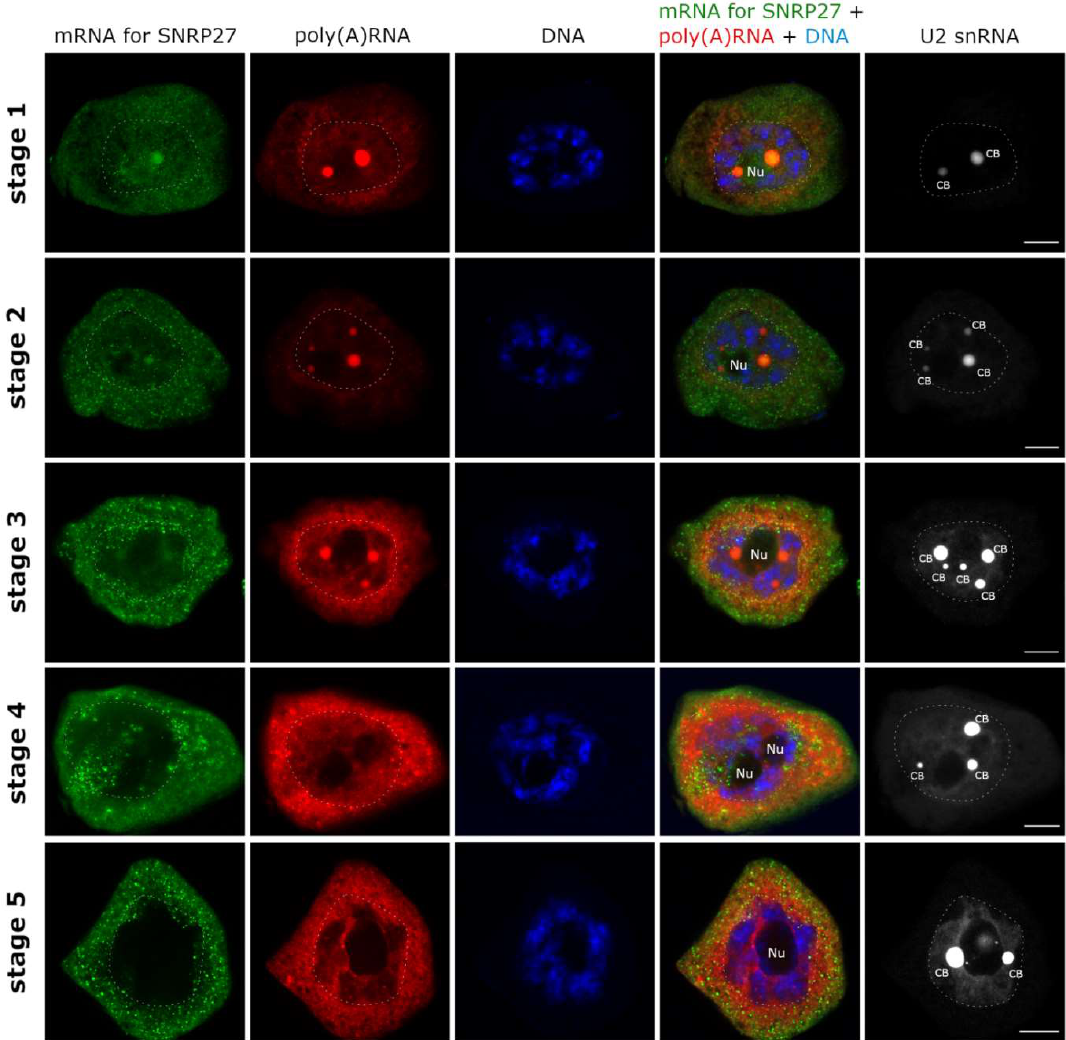
Figure 3. The first pattern of mRNA synthesis and export. Distribution of SNRP27 mRNA during poly(A) RNA cycle. SNRP27 mRNA (green) remains in the nucleus up to the 4th stage of poly(A) cycle. The exportstarts in the first stage and SNRP27 mRNA is present in cytoplasm until the end of the cycle. The transcript is localized to Cajal bodies (CBs) from the first to third stage of the cycle. SNRP27 mRNA (green), Poly(A) RNA (red), DNA (blue), U2 snRNA (white). The border between the nucleus and the cytoplasm is marked with a white dashed line. Bar—10 µ